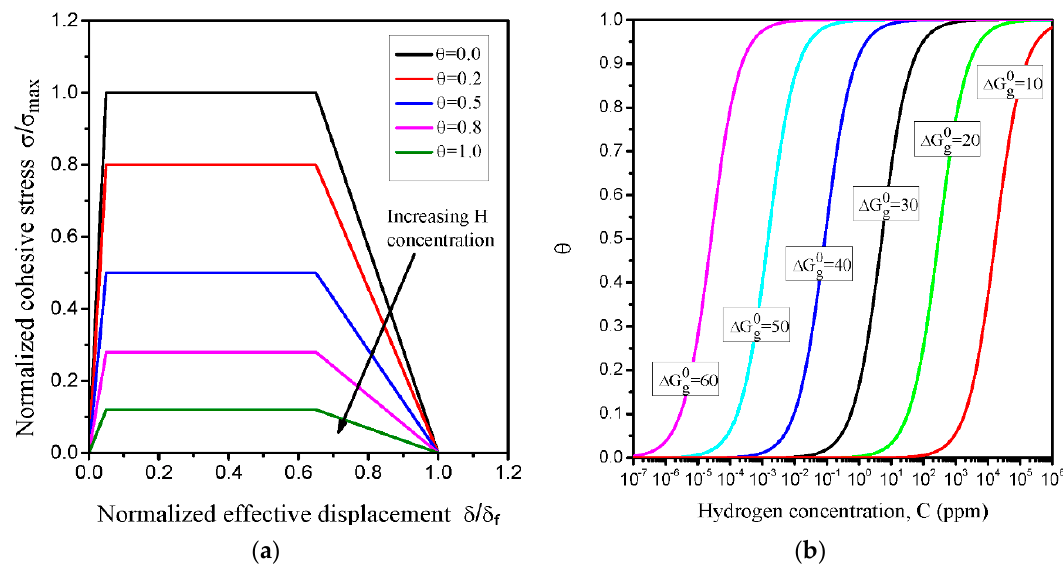
Figure 7. ( a ) Trapezoidal traction-separation law (TSL) for various values of hydrogen coverage θ ; ( b ) hydrogen coverage θ with hydrogen concentration for various levels of Gibbs free energy range of 10 to 60 kJ·mol − 1 .